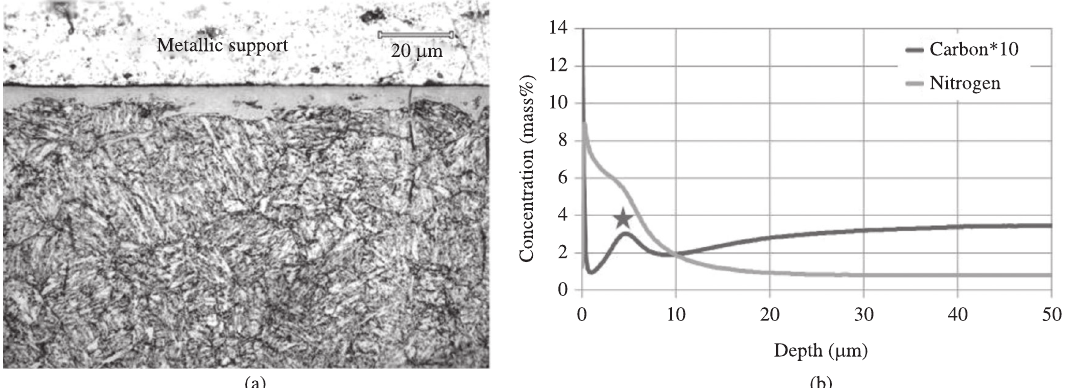
Figure 3. Sample 24N -6h. In (a) photomicrography of the cross section of the sample and in (b) GDOES profile. 2